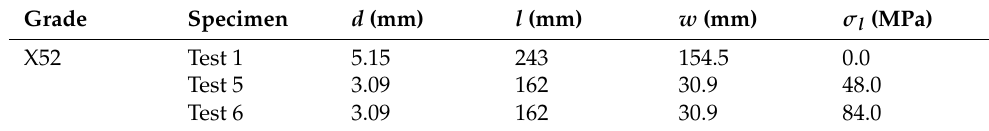
Figure 4. Application of symmetrical boundary conditions, internal pressure, compressive stress, and degrees of freedom (DOF) constraint for quarter pipe models. Table 5. Corrosion defect parameters for full scale burst tests by Bjorney et al. [50].